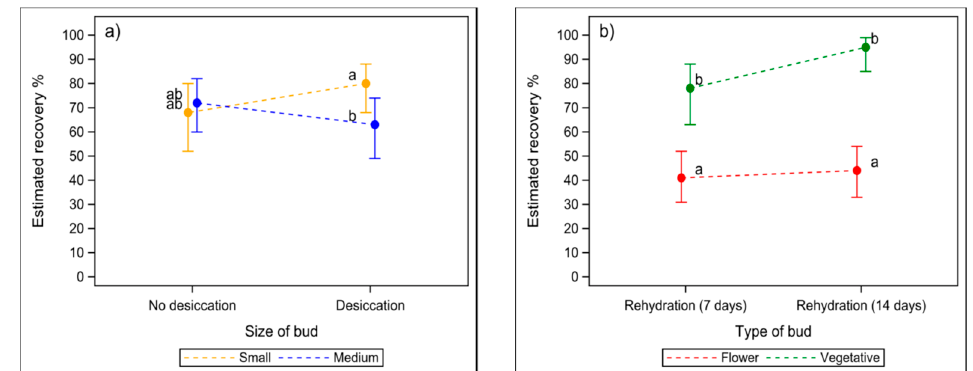
Figure 1. The estimated mean recovery of cryopreserved buds of blackcurrant cvs. Marski, Mikael, and Vilma according to ( a ) the pre-treatment of bud sections (desiccated or not) and the bud length, and ( b ) the bud type and rehydration time of bud sections. The effects of cultivar, pre-treatment, thawing method, rehydration, type of bud, size of bud, and all their 2-way and 3-way interactions were analysed using generalised linear mixed models. The length of the bars indicates the sizes of 95% confidence intervals. Letters a and b indicate significant differences ( p < 0.05) in estimated recovery rate in vitro between treatments.